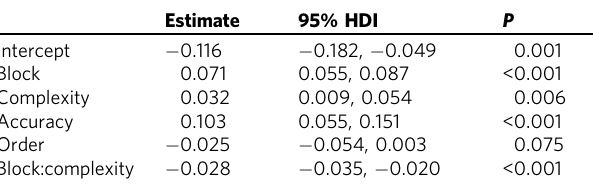
Table 4 Results of the Bayesian-estimated linear mixed effects regression model predicting attention compression.